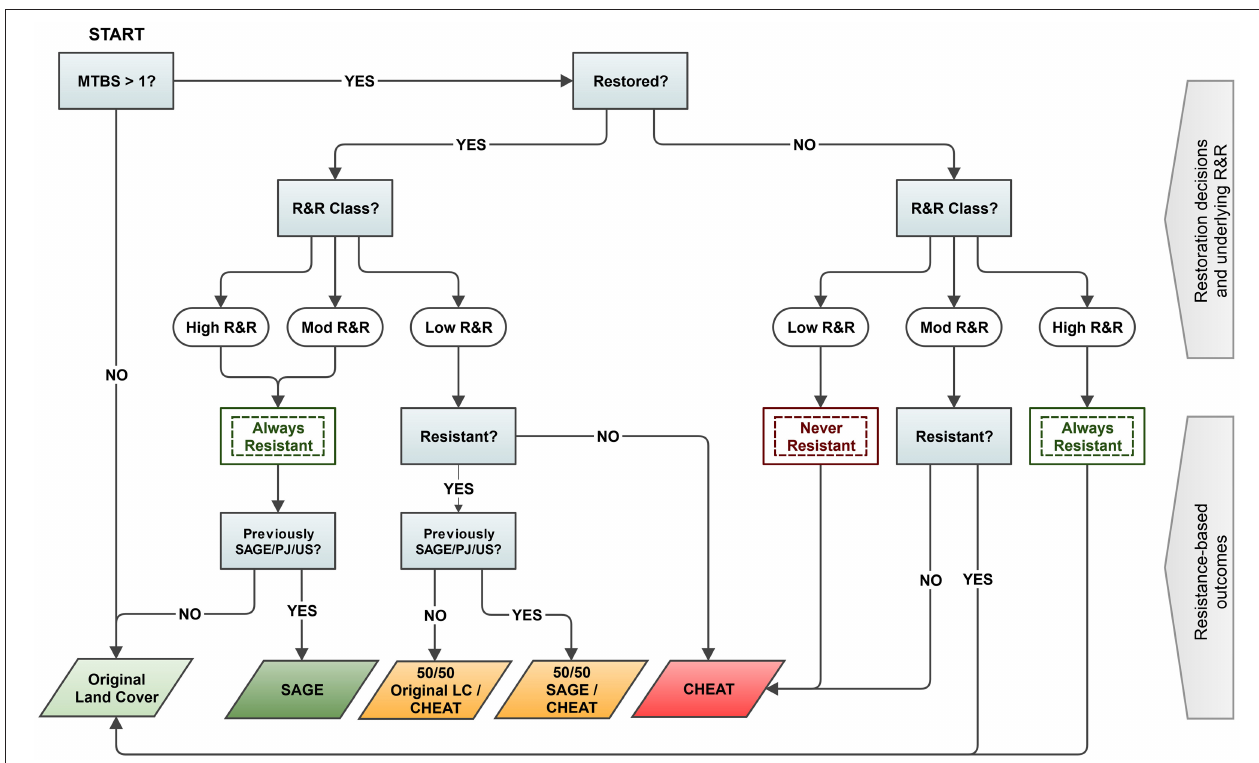
FIGURE 8 | Diagram of the decision model used to simulate outcomes of restoration decisions on land cover change (900 m 2 ) variation in burn-severity and resilience to disturbance and resistance to invasion (RandR) index classes. Local conditions may add uncertainty for resistance to cheatgrass invasion under some moderate and low RandR soil temperature and moisture regimes, so the model generates both Resistant and Not-Resistant outcomes in these cases following the decision to restore or not restore. Restored decisions assume active seeding or planting of sagebrush. Subsequent post-fire land cover surfaces can be used to model changes in sage-grouse habitat selection or suitability. Used with permission from Ricca et al.